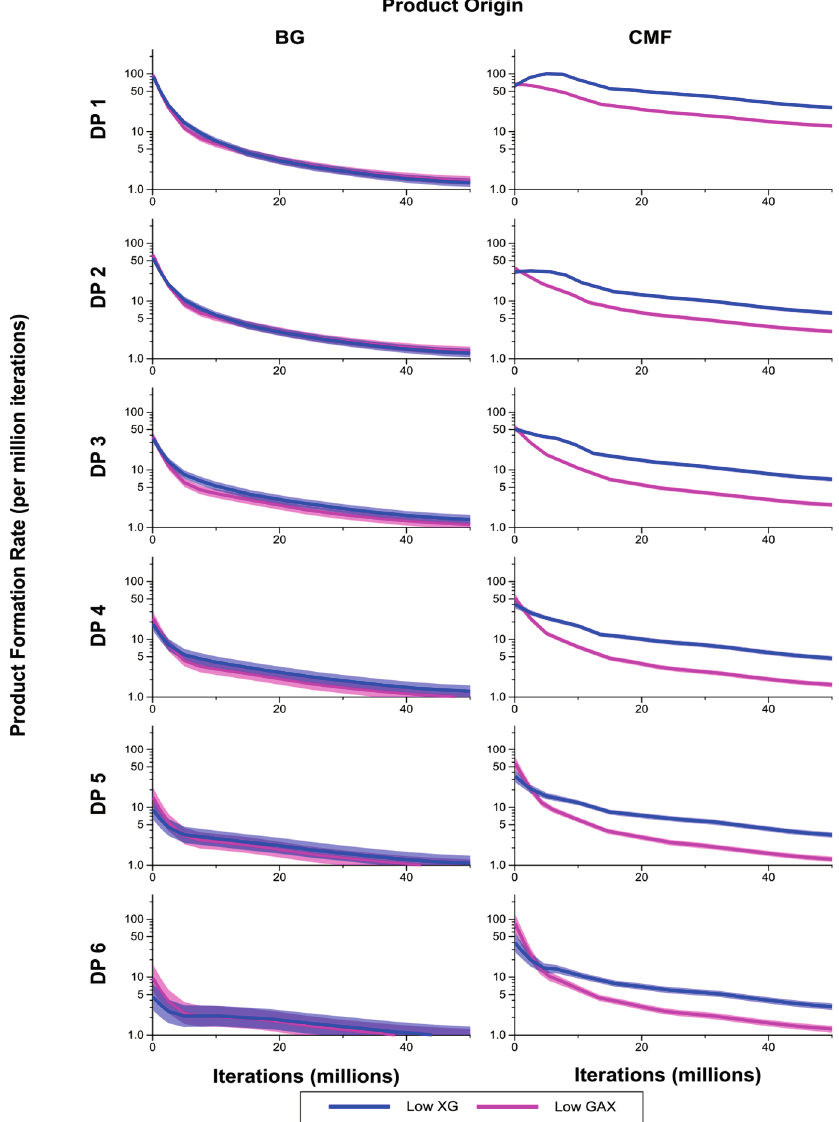
Figure 8. Breakdown products (monosaccharides and oligosaccharides) over time (iterations) for Low GAX and Low XG walls, showing rate of formation of products by degree of polymerisation (DP) from (1,3;1,4)- β -glucan (BG) and CMF. The shaded region represents a 95% Least Significant Interval so that the two curves are significantly different at the 5% level where the bands do not overlap. The solid line in the middle indicates the mean